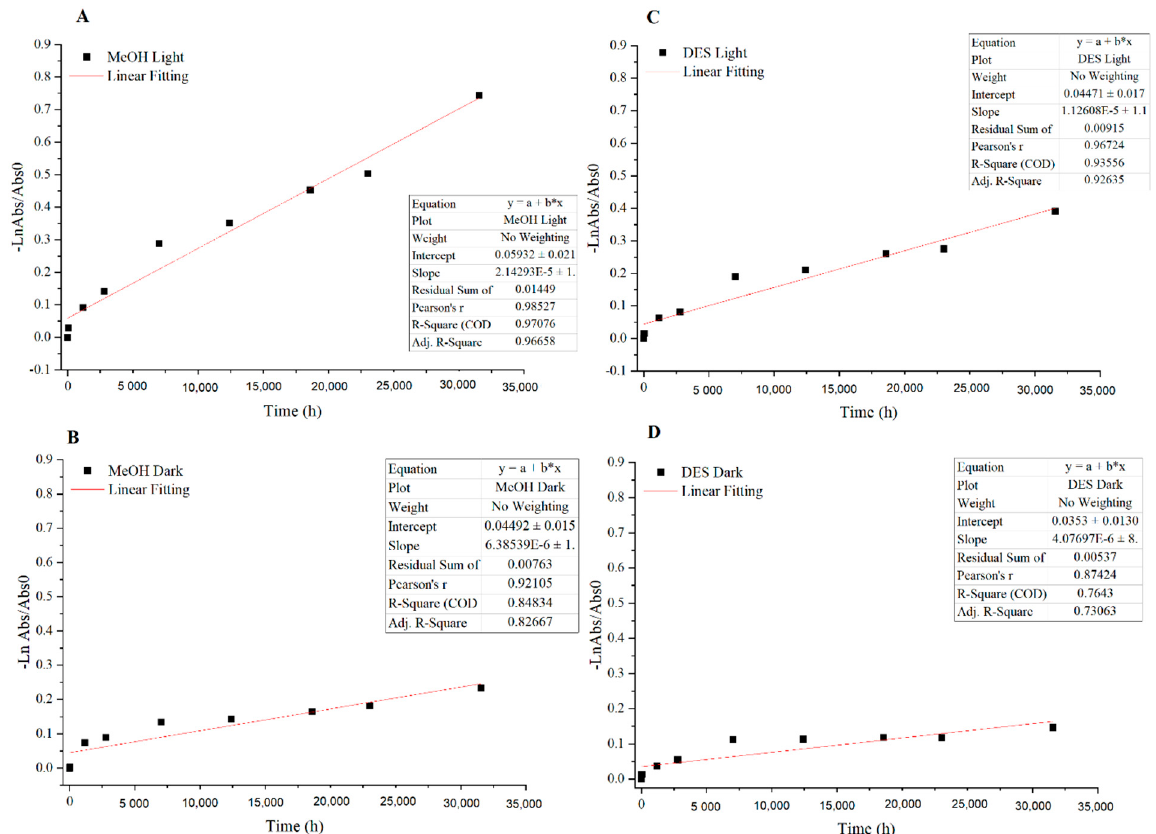
Figure 4. Degradation kinetics of anthocyanins extracted with MeOH ( A ) light and ( B ) Dark and Ch-Xyl ( C ) Light, ( D ) Dark in both conditions. The correlation coefficients of all curves are R 2 ≥ 0.99. Table 7. Degradation constant ( K d ) and half-life ( t 1/2 ) values for anthocyanins extracted from jussara. Solvent